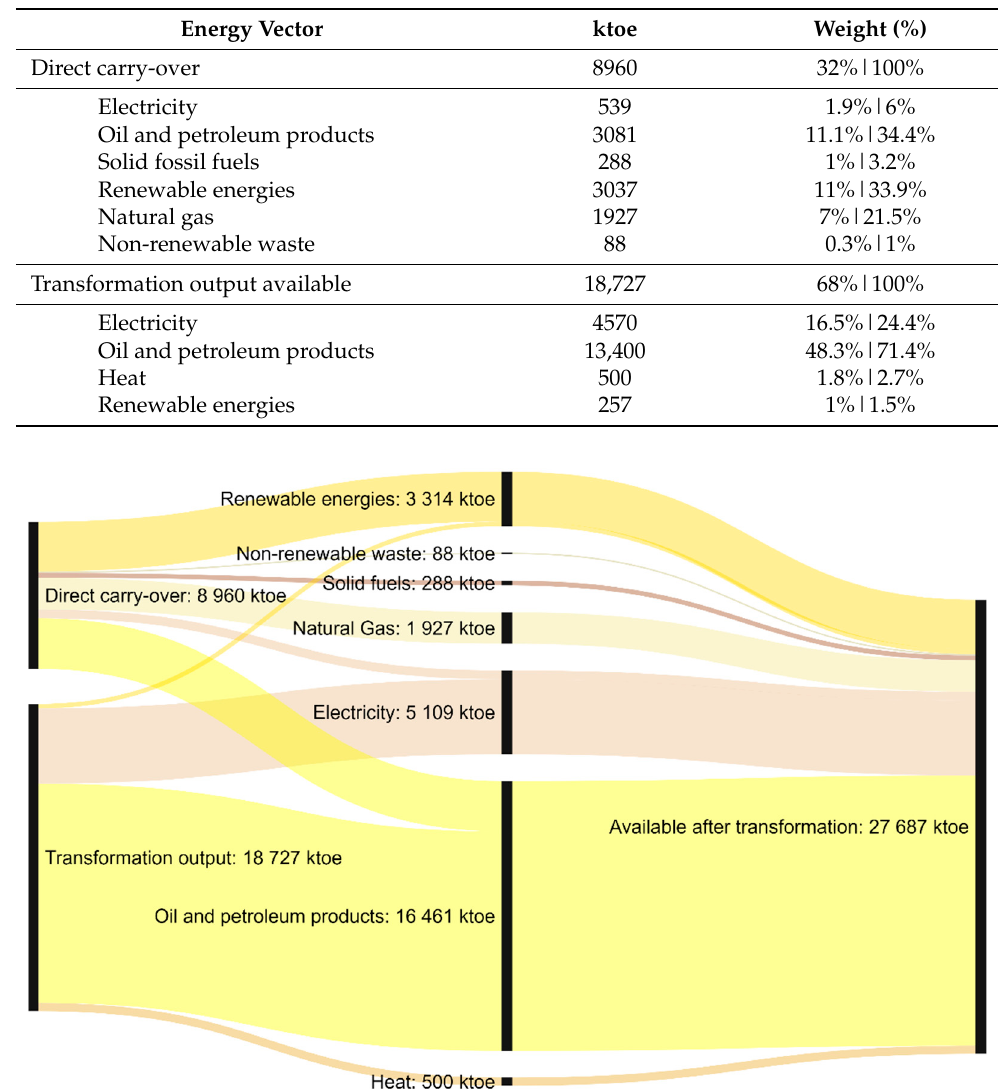
Table 4. Energy and weight of each energy vector in Portuguese energy mix available after transformation in 2019 (from Eurostat data).